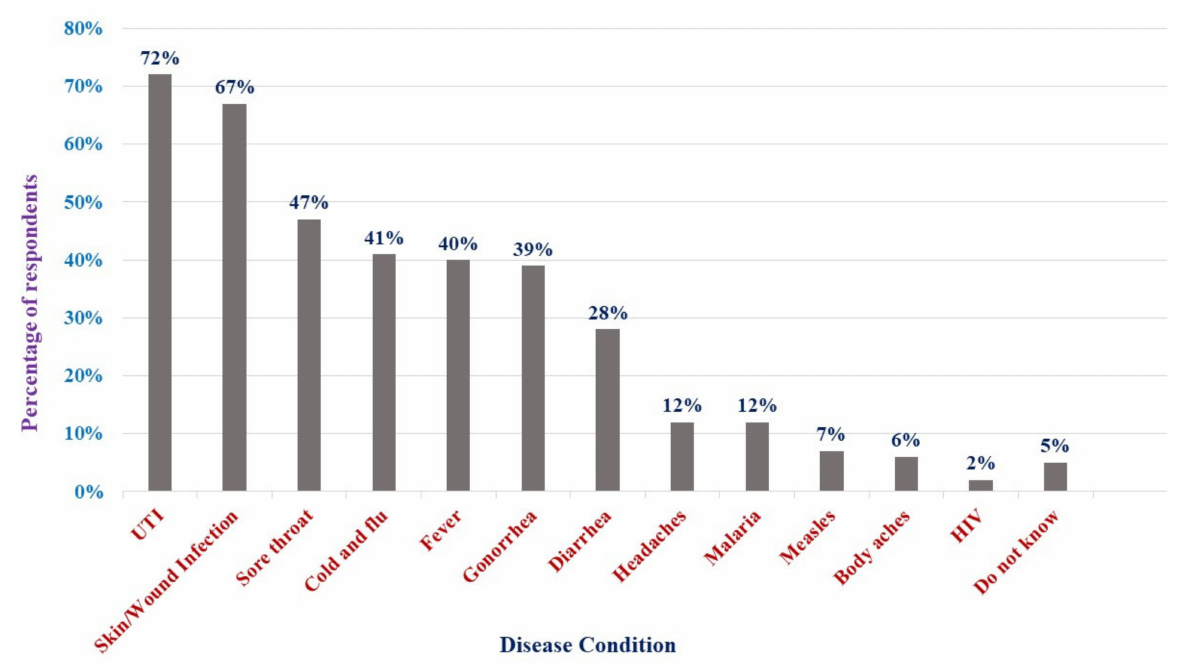
Figure 5. Percentages of participants who reported acceptable antibiotic usage in the different circumstances of the illness. HIV, human immunodeficiency virus; UTI, urinary tract